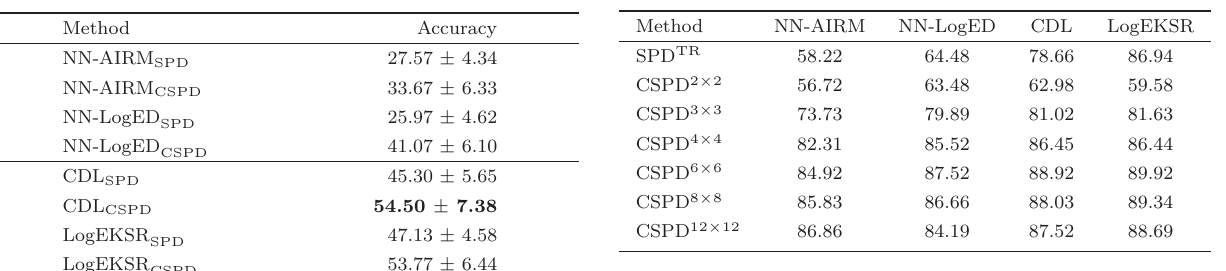
Table 4 Effect of block size on average